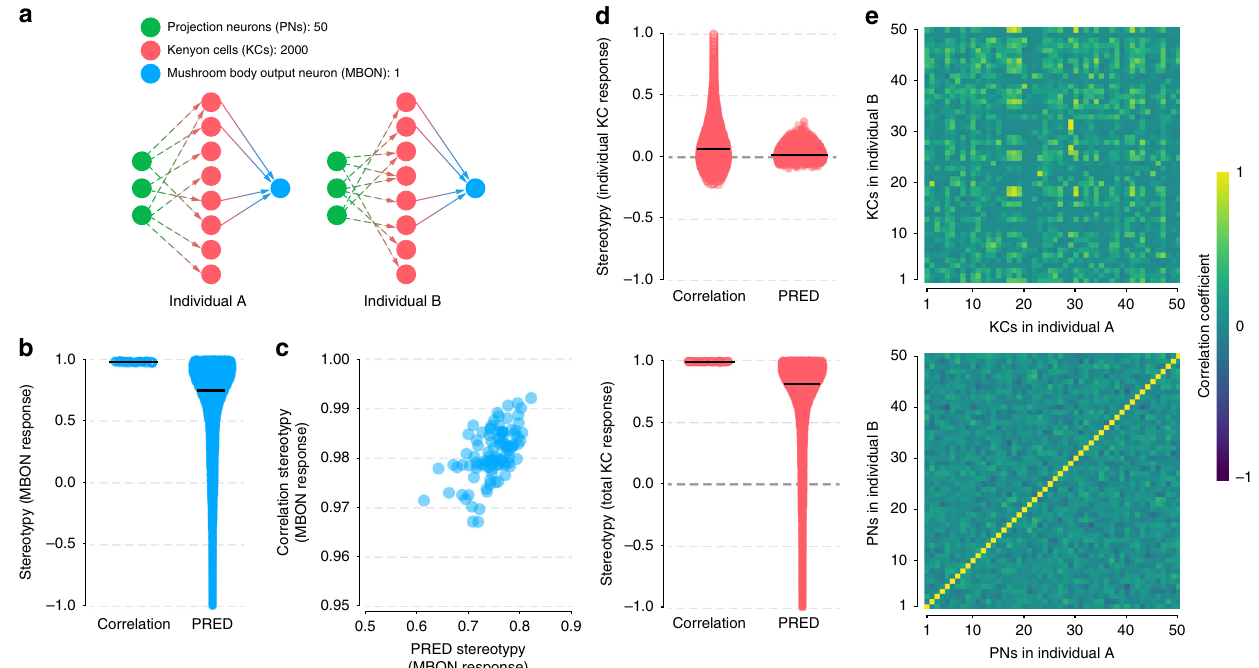
Fig. 2 Stereotypy in model MBONs and KCs. a Schematic representation of the simulated mushroom body networks in two different individuals. Projection neuron (PN, green) to Kenyon cell (KC, pink) connections are random and vary across individuals. The number of KCs connected to the mushroom body output neuron (MBON, blue) was kept same across individuals. b Correlation stereotypy and PRED stereotypy in MBON response in a realistic network with random PN-KC connections across individuals; for correlation, n = 100 points corresponding to different network iterations with different random seeds; for PRED, n = 495000 points (100 iterations × 950 odor pairs from 100 odors). c Scatter plot of correlation stereotypy versus PRED stereotypy in MBON response for the same simulations as in ( b ) shows that both metrics behave similarly. The PRED stereotypy is averaged over all 4950 odor pairs within a network iteration ( n = 100 iterations). d (top) Correlation stereotypy and PRED stereotypy in individual KC response for the same simulations as in ( b ). Both metrics con fi rm the absence of stereotypy in individual KCs, n = 100537 KCs that responded to at least one odor in both individuals, out of the 200,000 KCs from 100 network iterations. (bottom) Correlation stereotypy and PRED stereotypy in total KC response for the same simulations as in ( b ); number of data points same as in ( b ). e Correlation between the responses of the PNs (bottom) and the KCs (top) in two individuals in a simulation. The correlation is calculated using the 100-length vector (responses to 100 odors) for each pair of PNs (50 in total) or for each pair of KCs among the fi rst 50 KCs (by spatial ordering) that responded to at least one odor in both Fig. 2c and d; other network parameters are analyzed in later sections).